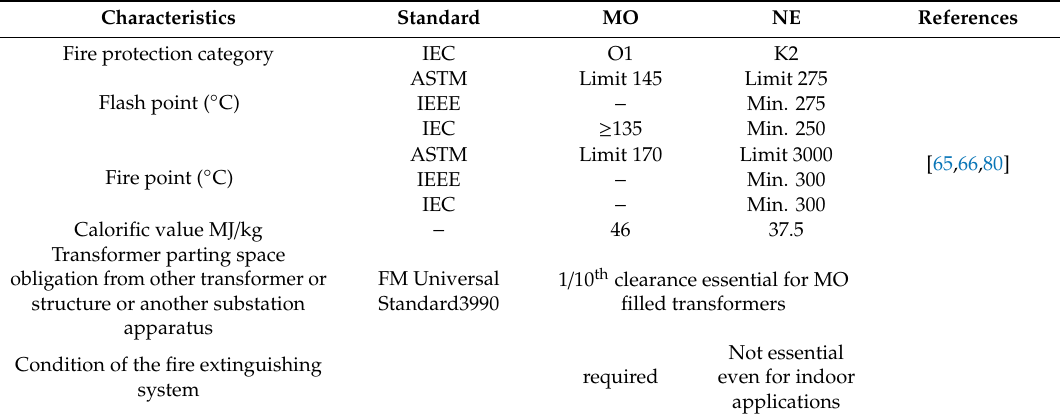
Table 10. Fire and flash point particulars of dielectric fluids.